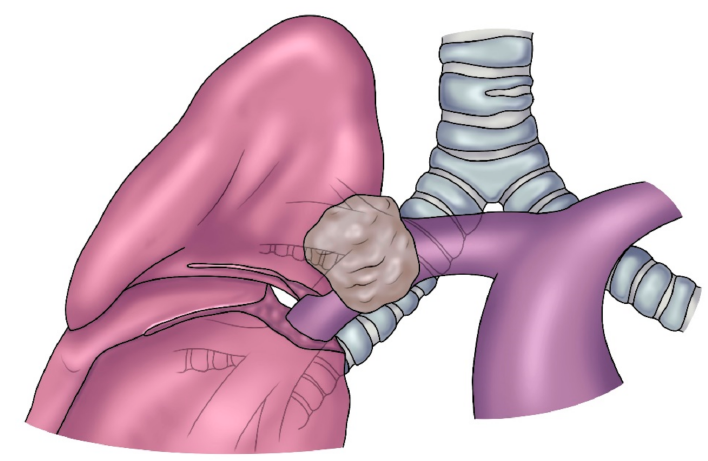
Figure 1. A tumor of the right upper lobe infiltrating the PA (posterior